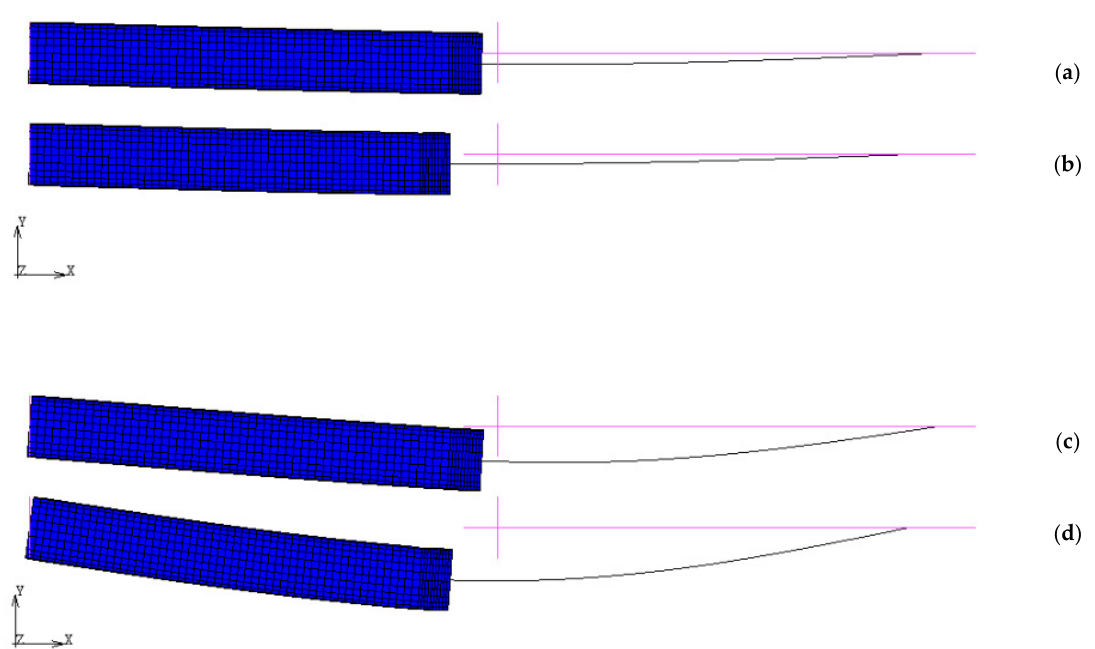
Figure 8. Deformed configuration (Scale Factor × 50) of the cylinder tube, while pushing under its own weight: ( a ) reference and ( b ) composite Case D configuration considering small strain assumption, ( c ) reference and ( d ) composite Case D configuration considering large rotation assumption.